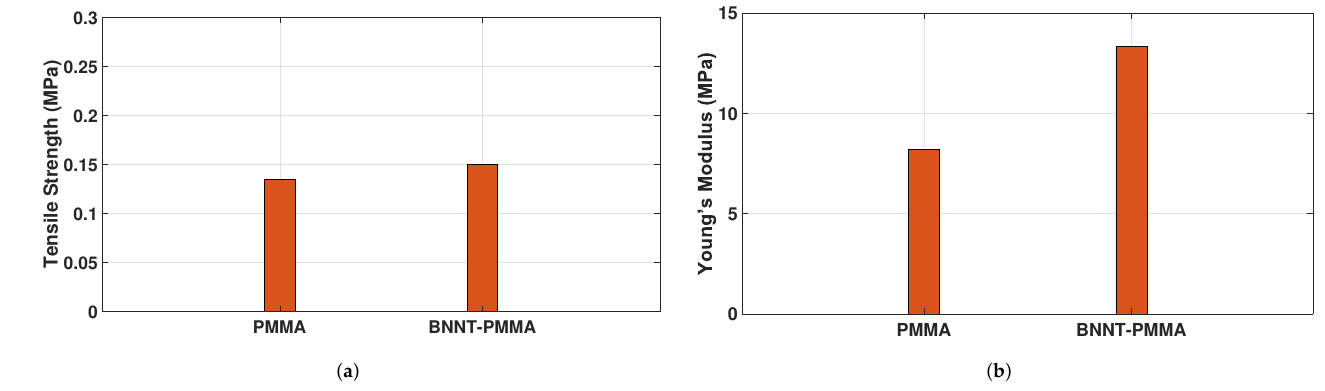
Figure 5. Tensile strength properties enhancement in BNNT-PMMA nanocomposite: ( a ) the average tensile strength; ( b ) the average Young’s modulus.